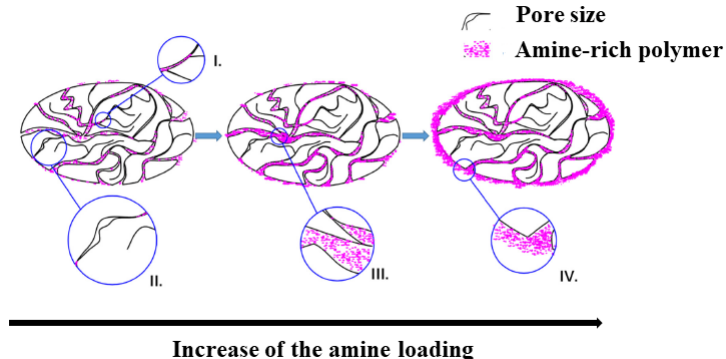
Figure 7. Scheme of the pore blocking process in a clay mineral by an amine-rich polymer. ( I ) Surface area reduction due to micropores blocking; ( II ) surface area reduction due to pore necks blocking; ( III ) multiple-layer amine-rich polymer film and ( IV ) clay mineral particle covered by the amine-rich